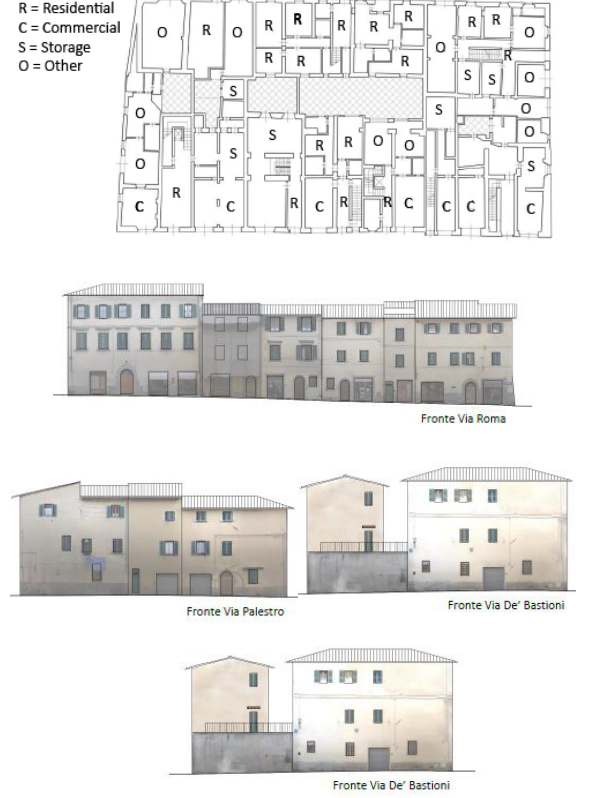
Figure 6. Planimetry of the referred aggregate (ground floor only); photogrammetry of the façades of the buildings (Bonaguidi, 2019).